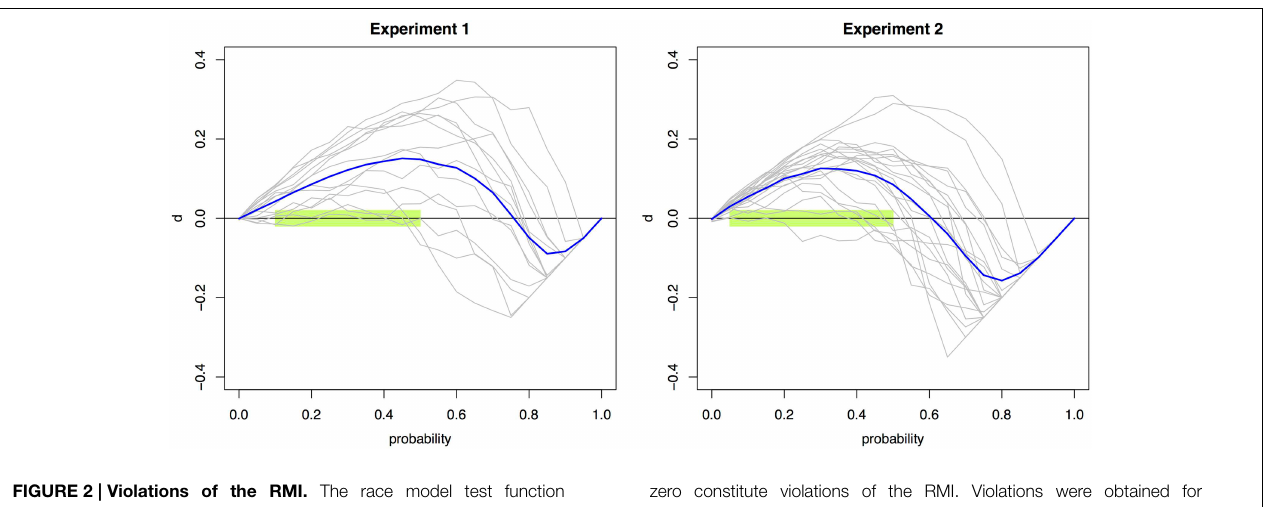
zero constitute violations of the RMI. Violations were obtained for the probability points 0.05–0.50 using multiple t -tests with a Bonferroni-corrected significance level of 0.0026. This region is highlighted in light green.